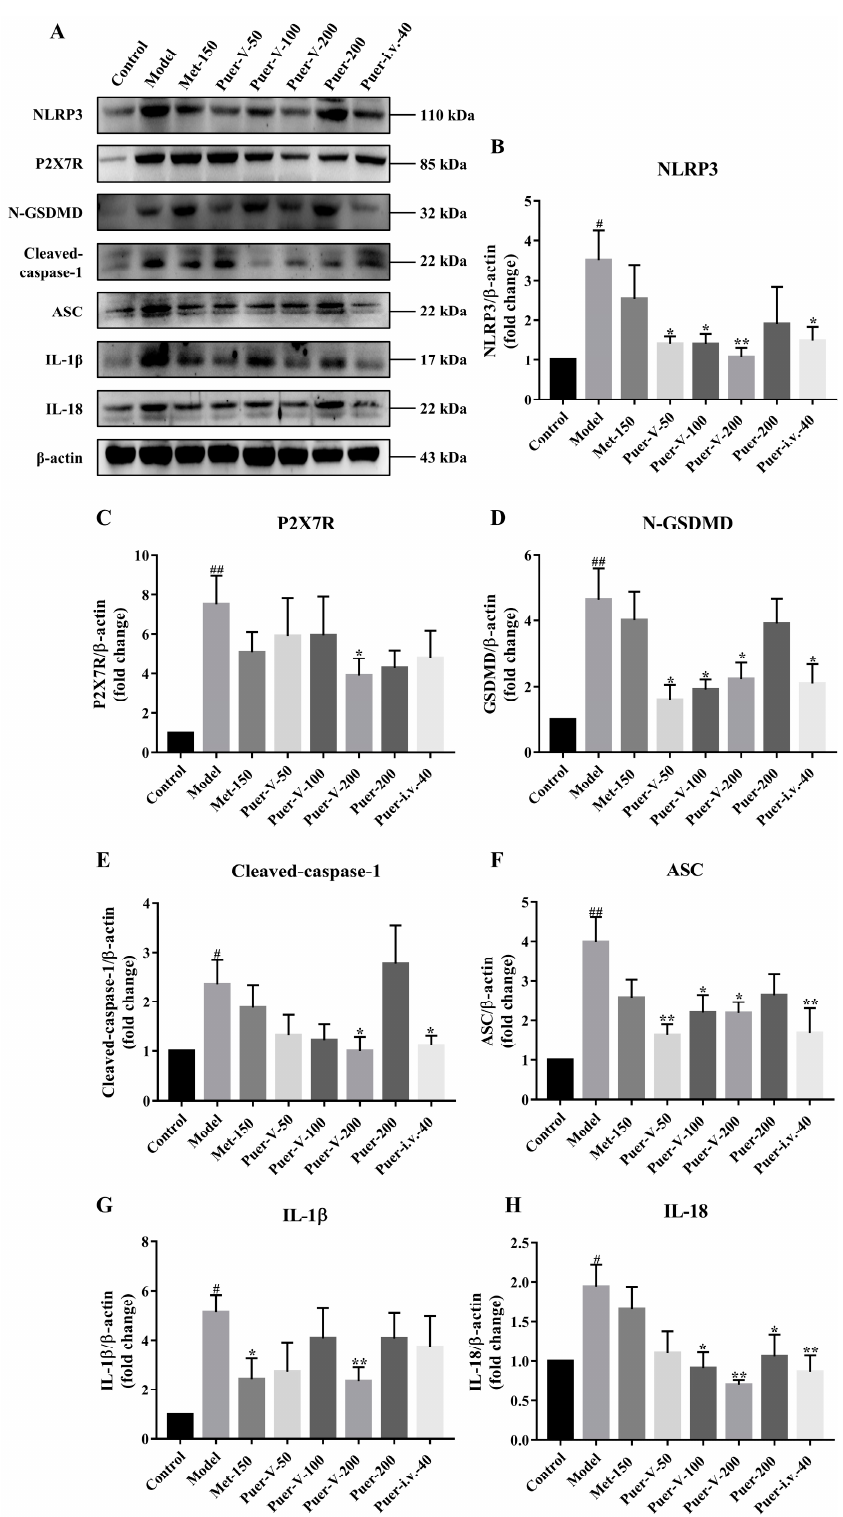
Figure 11. Puerarin-V hindered NLRP3-Caspase-1-GSDMD mediated pyroptosis signaling pathway activation. ( A – H ) Western blot analyses were performed for NLRP3, P2X7, N-GSDMD, Cleaved- caspase-1, ASC, IL-1 β , and IL-18 expression, and normalization was performed using β -actin expres- sion. The data are represented by mean ± SEM (n = 6). # p < 0.05 and ## p < 0.01 vs. control group. * p < 0.05 and ** p < 0.01 vs. model